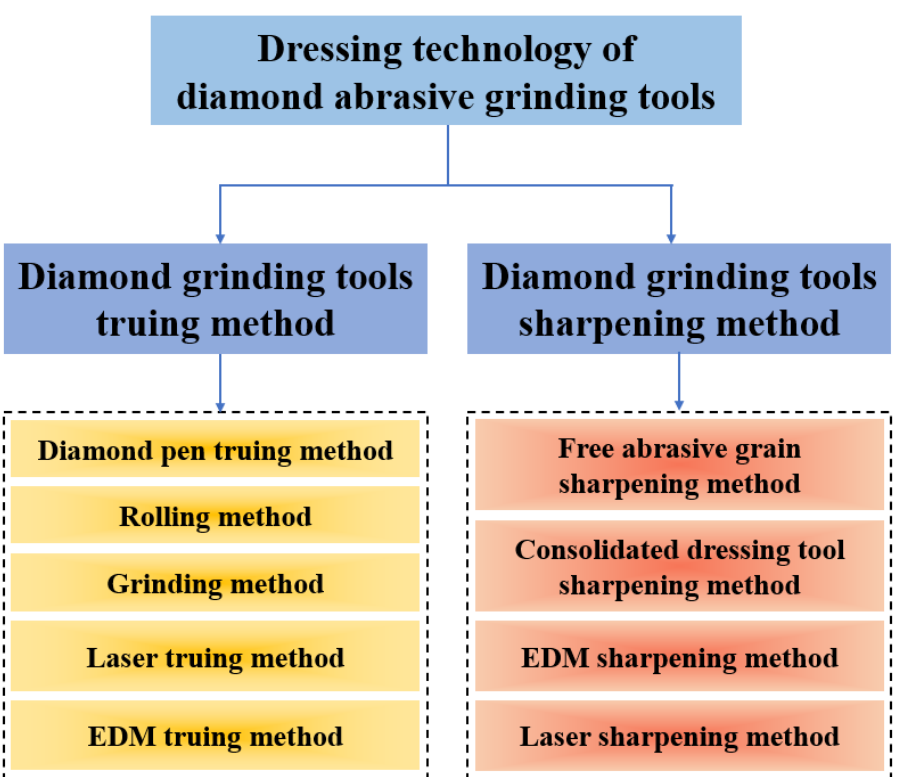
Figure 1. Diamond abrasive grinding tools dressing technology.